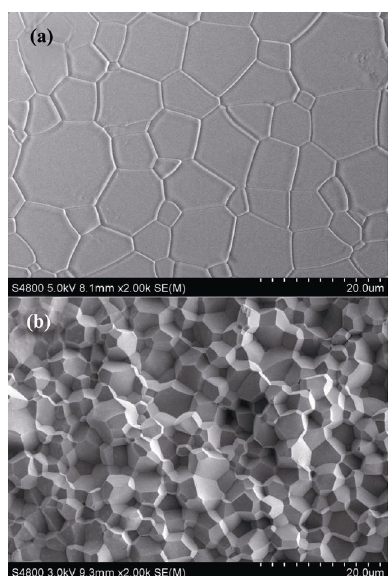
Fig. 5 SEM micrographs of the polished surface (a) and fracture surface (b) of YAG transparent ceramic sample.